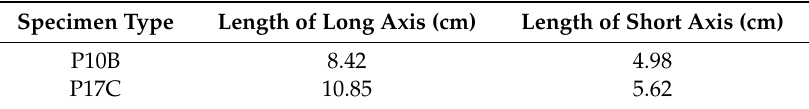
Figure 7. Planar damage areas of TTAI reinforced composites: ( a ) P10B; and ( b ) P17C. Table 7. Dimensions of the damaged areas of P10B and P17C.